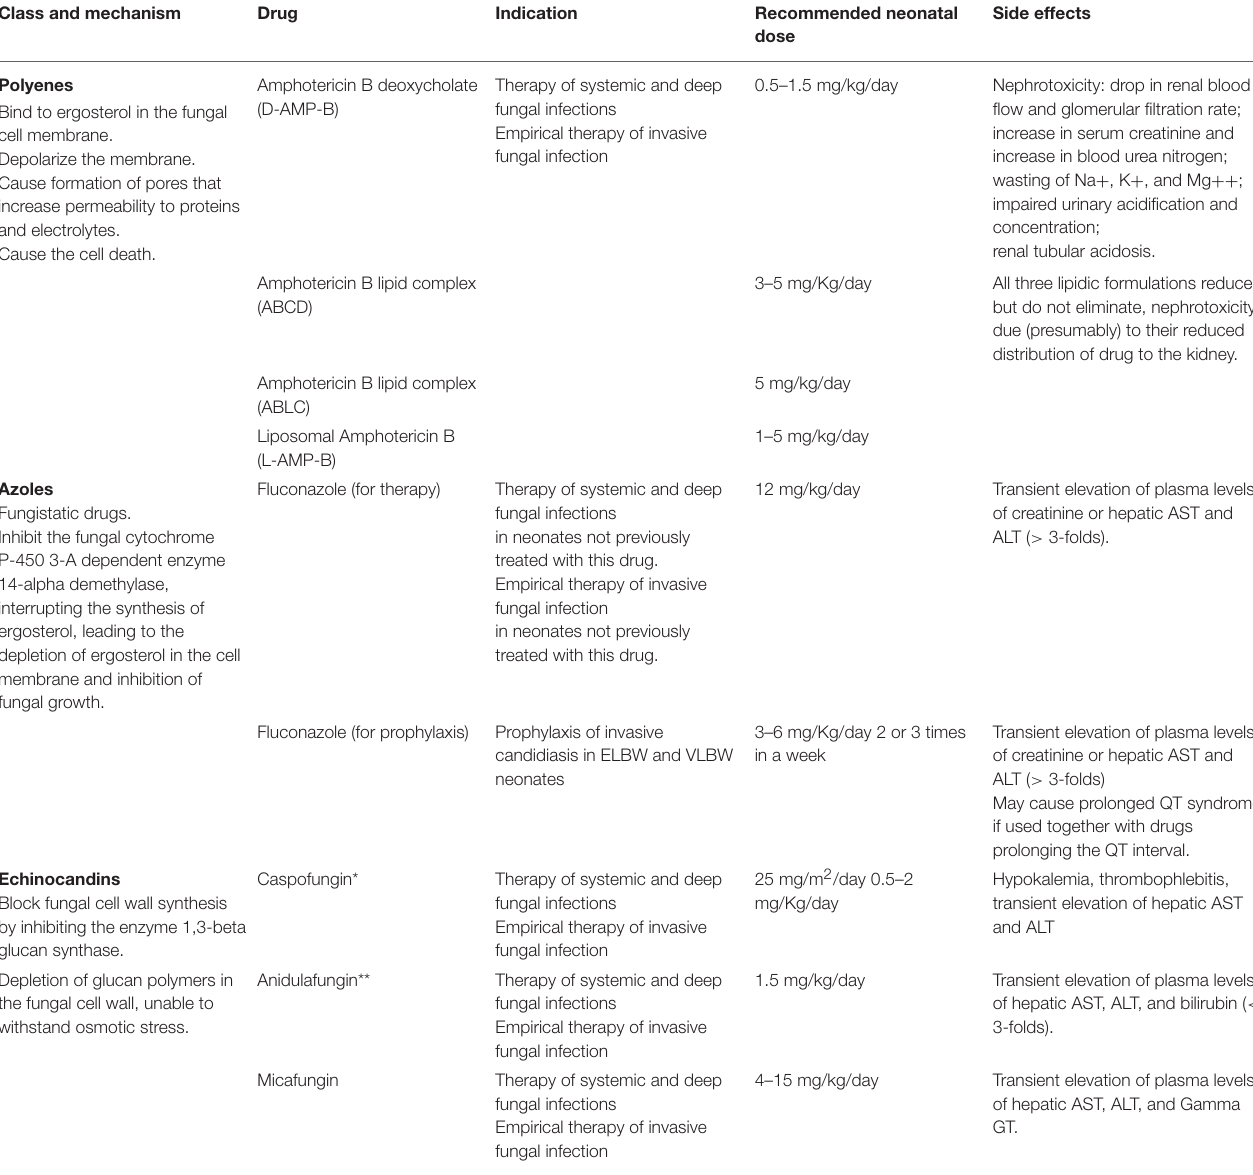
TABLE 1 | Antifungal drugs currently used in infants with ICI. Class and